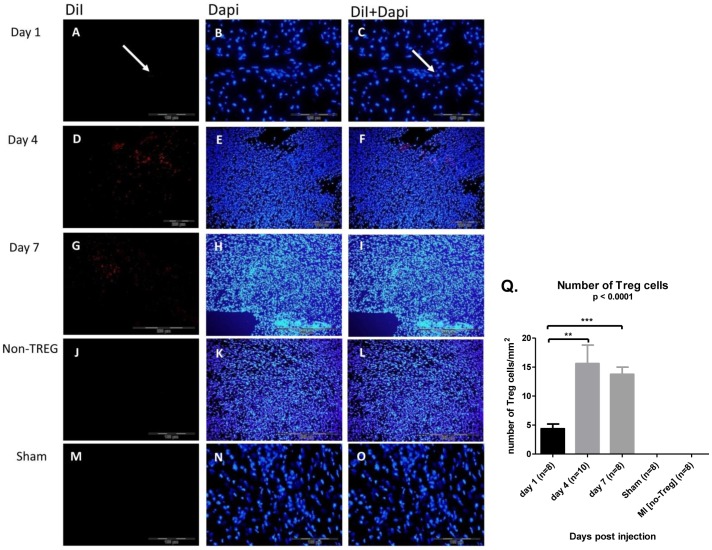
Homing of Tregs to ischemic hearts after their intravenous injection.(A–C) Frozen heart sections 1 day after intravenous (i.v.) injection of DiI-labeled Tregs. (D–F) Frozen heart sections 4 days after i.v. injection of DiI-labeled Tregs. (G–I) Frozen heart sections 7 days after i.v. injection of DiI-labeled Tregs. (J–L) Frozen heart sections 4 days after i.v. injection of DiI-labeled no-Tregs. (M–O) Frozen heart sections 4 days after i.v. injection of DiI-labeled Tregs sham mice. (Q) Treg numbers are significantly increased by day 4 post i.v. injection. p based on Kruskal-Wallis; **p<0.001, ***p<0.0001 based on Dunn's multiple comparison test. n (day 1) = 8; n (day 4) = 10; n (day 7) = 8, MI no-Treg cells (n = 8), Sham (n = 8).